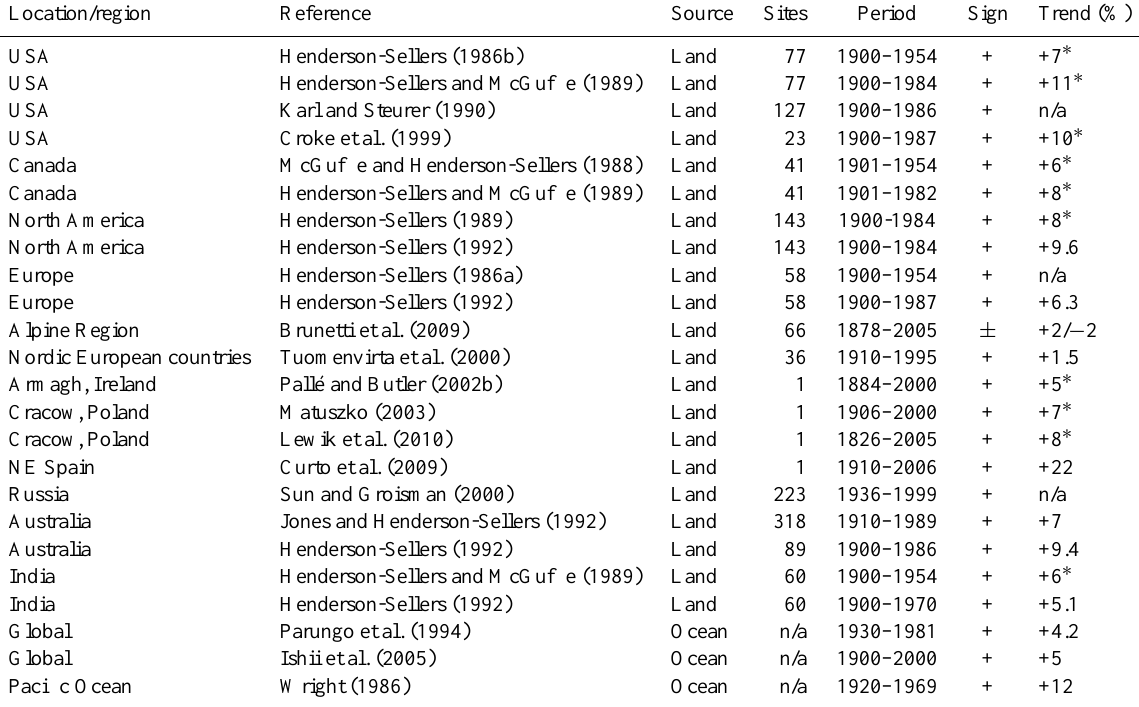
Table 1. Summary of the reviewed studies reporting trends of TCC before the second half of the 20th century, including information regarding the location/region studied, source of the observations (land or ocean), period, and sign and magnitude of the trends (%) over the specific periods of each